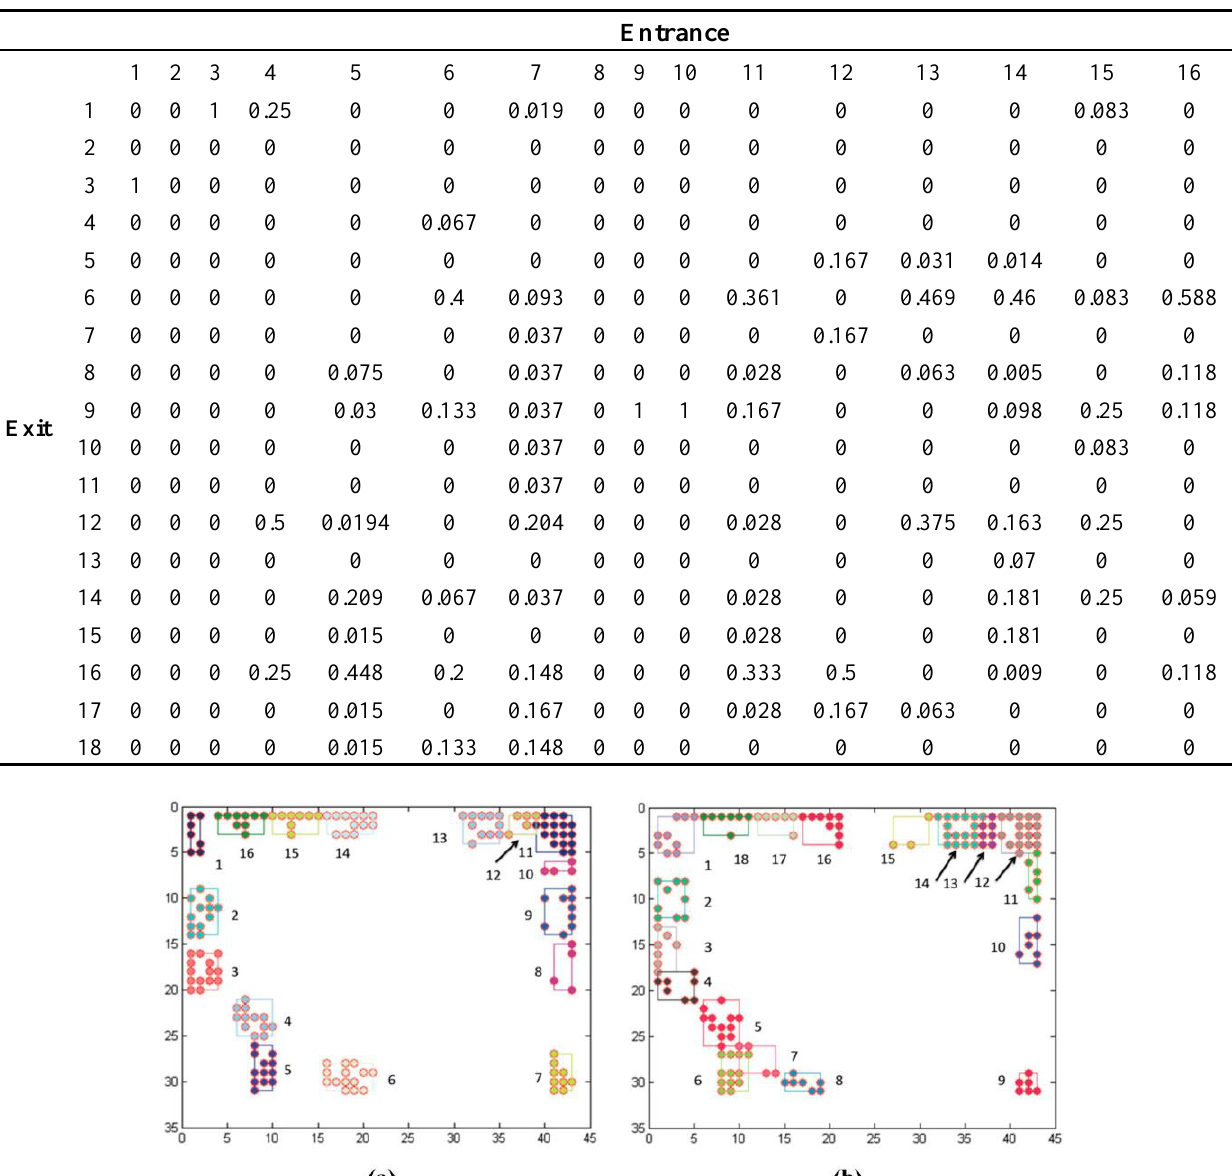
Table 2. Entrance and exit probabilities for each entrance and exit pair derived from scene activities.